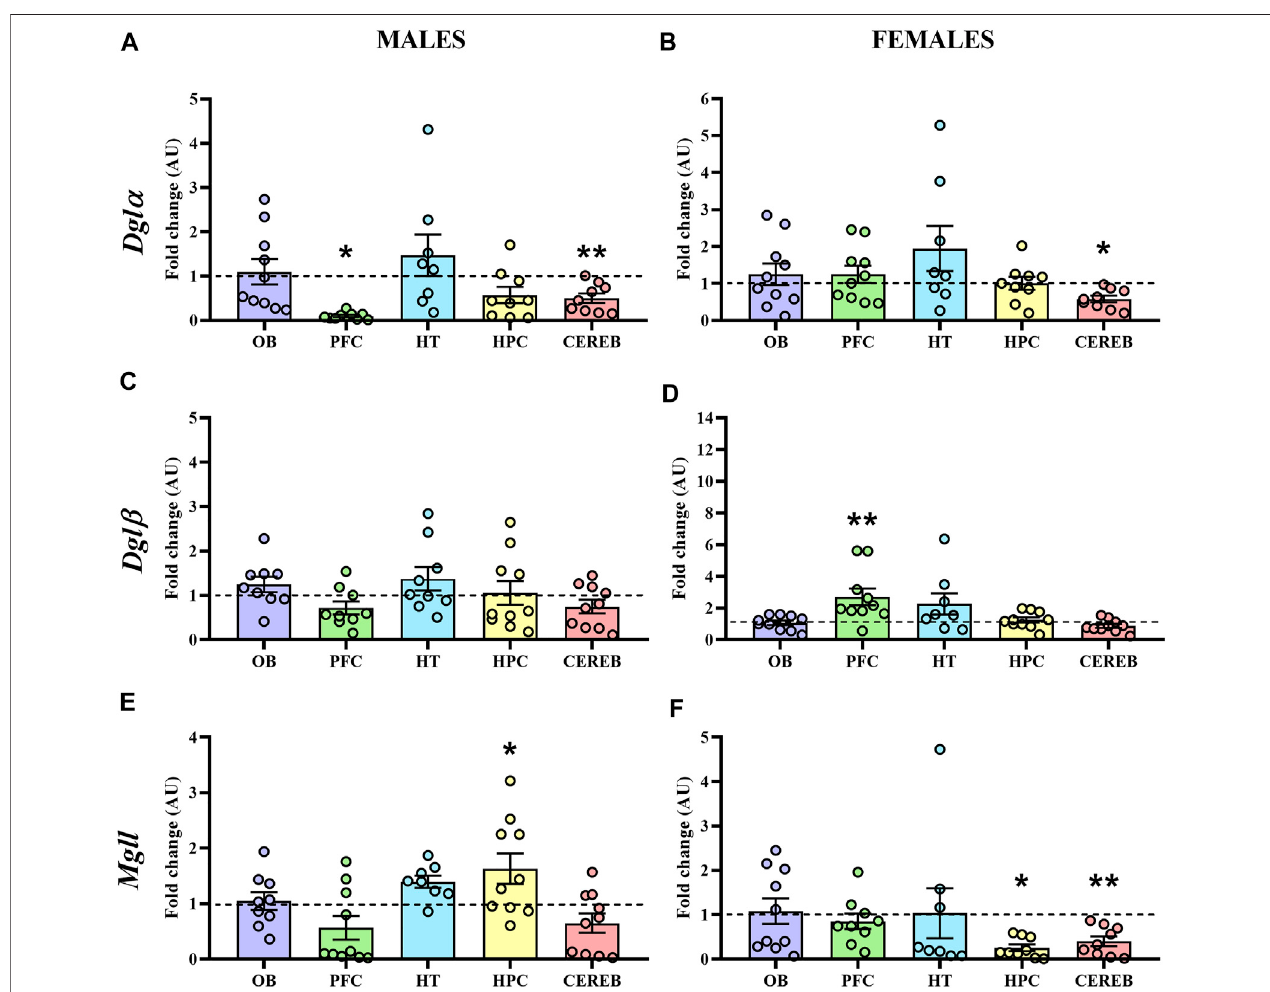
FIGURE 6 | Gene expression of the enzymes involved in the 2-AG signaling in WT (male n = 10; female n = 10) and APP/PS1 (male n = 10; female n = 10) mice at 3 months ofage.RT-qPCRassaywasperformed toanalyze theexpression of Dgl α , Dgl β and Mgll in (A,C,E) males and (B,D,F) females, respectively. The X axis shows the fi ve brain-regions analyzed: olfactory bulb (OB), prefrontal cortex (PFC), hypothalamus (HT), hippocampus (HPC), and cerebellum (CEREB). The Y axis shows the mRNA expression asa foldchange comparingmale and female APP/PS1 mice with its correspondingWT (representedas adashed line). Values are presented as the mean ± SEM. * p < 0.05, ** p < 0.01, vs. WT group (genotype effect); (Mann – Whitney